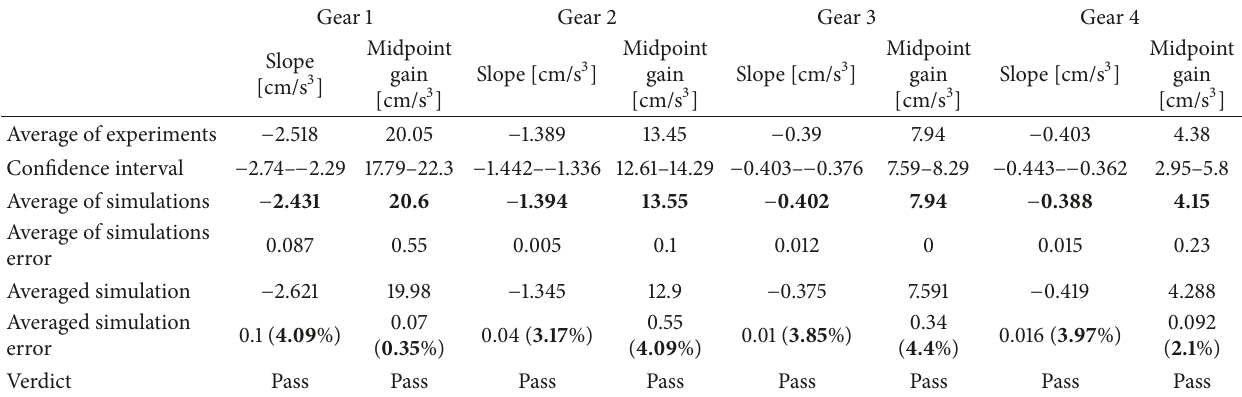
Table 11: Validation results Maneuver Long II: steady-state